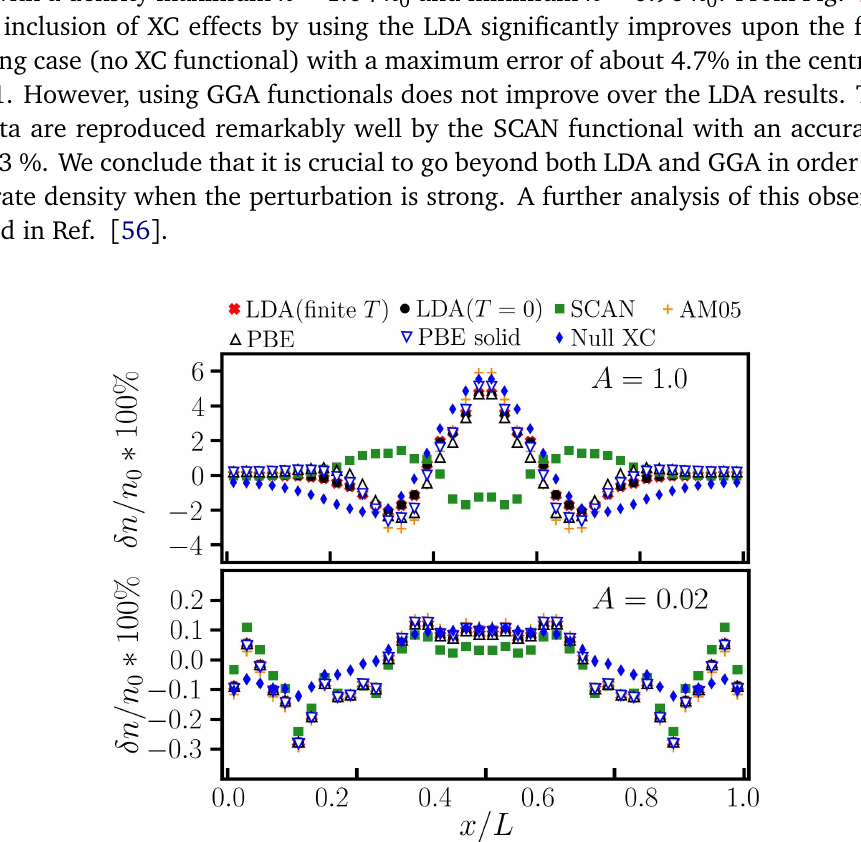
Figure 4: Relative error of the density using different XC functionals compared to the = QMC data at θ = 1 and r s